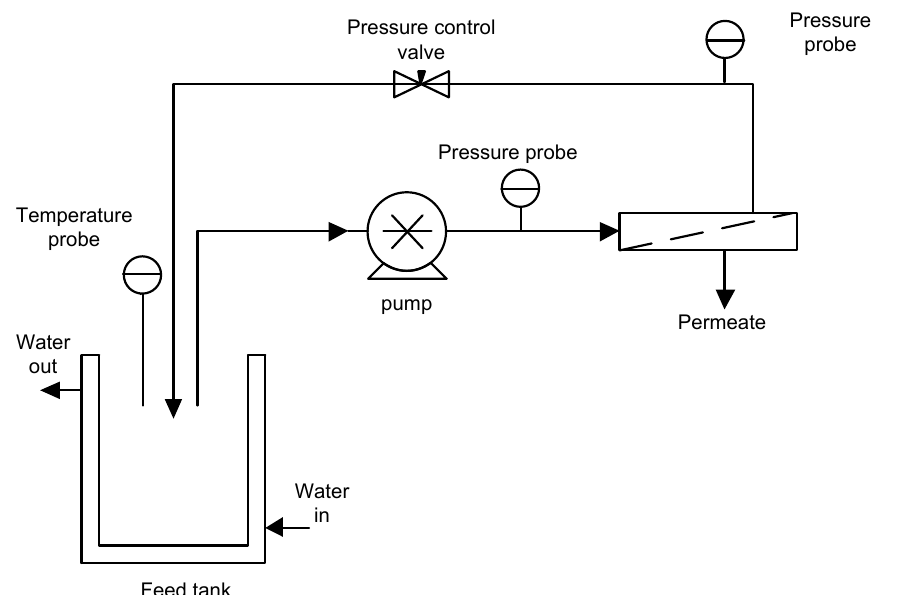
Figure 2. Schematic diagram of Microfiltration experimental set-up.